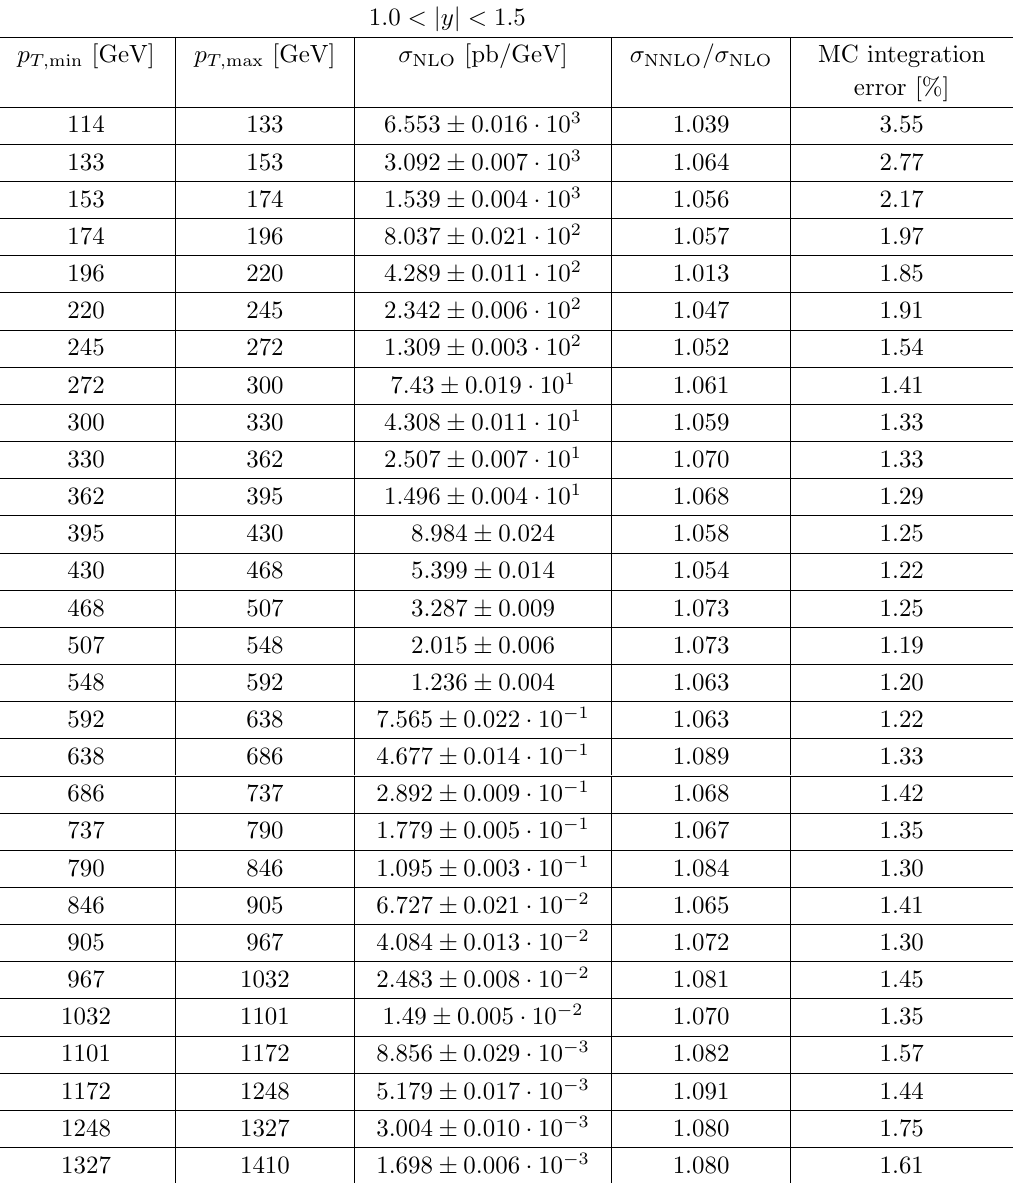
Table 3 . NLO QCD single-inclusive cross section and NNLO QCD K-factors in the rapidity slice y < 1 : 1 : 0 < j j